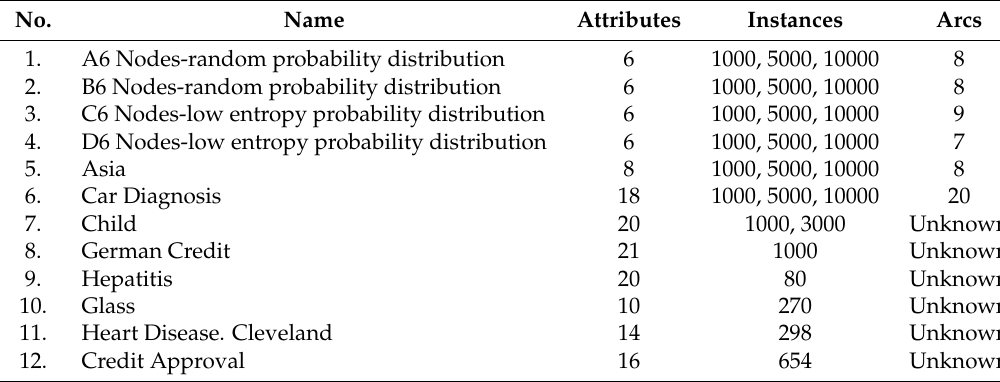
Table 1. Databases used in the